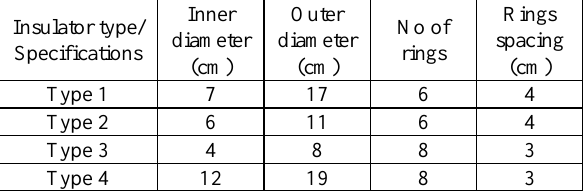
Table 1. Specifications of four types of insulators in the dataset Insulator